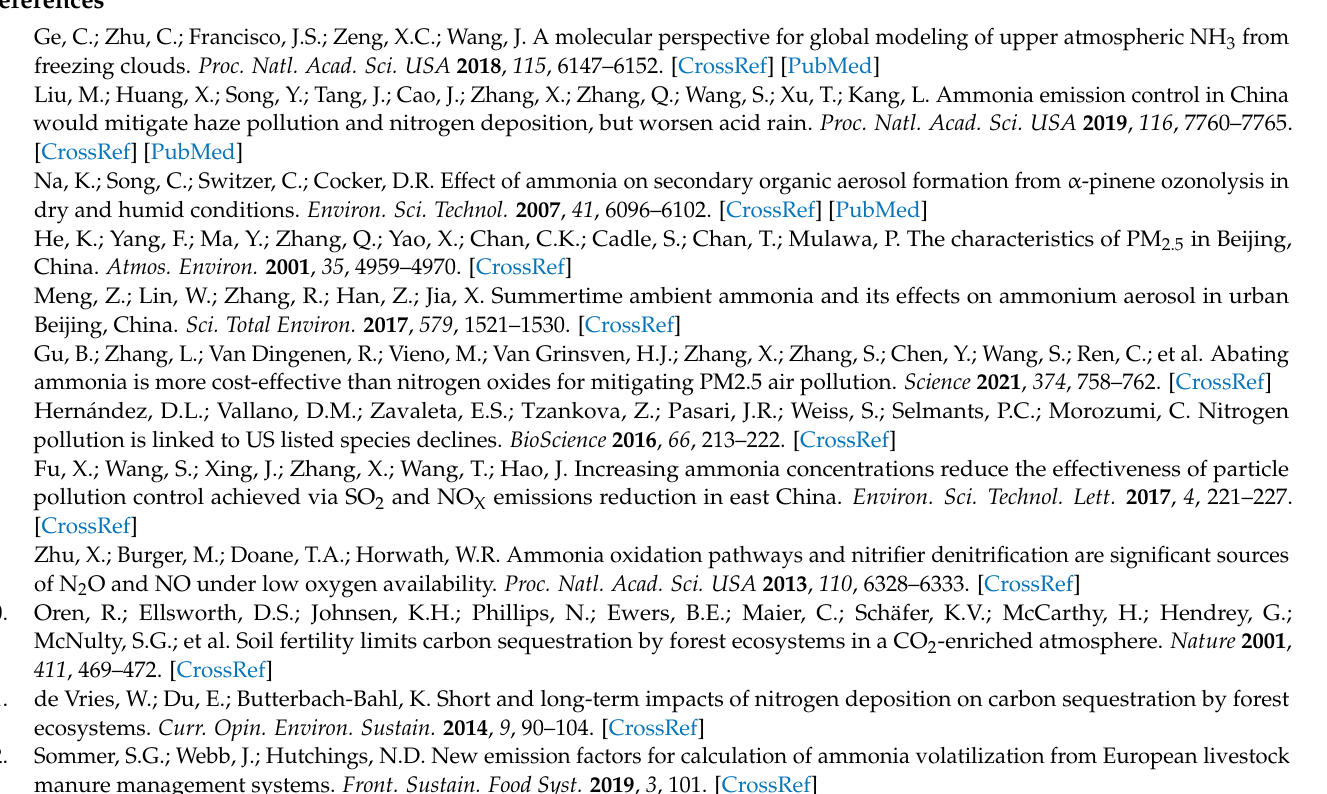
Figure S7: Annual average NH 3 emissions for 10 groups of feedlots in the inventory. Figure S8: Monthly average NH 3 emissions for 10 groups of feedlots in the inventory. Figure S9: Comparison of IASI-based NH 3 emissions with EDGAR from 2008 to 2018. Table S1: NH 3 lifetimes reported